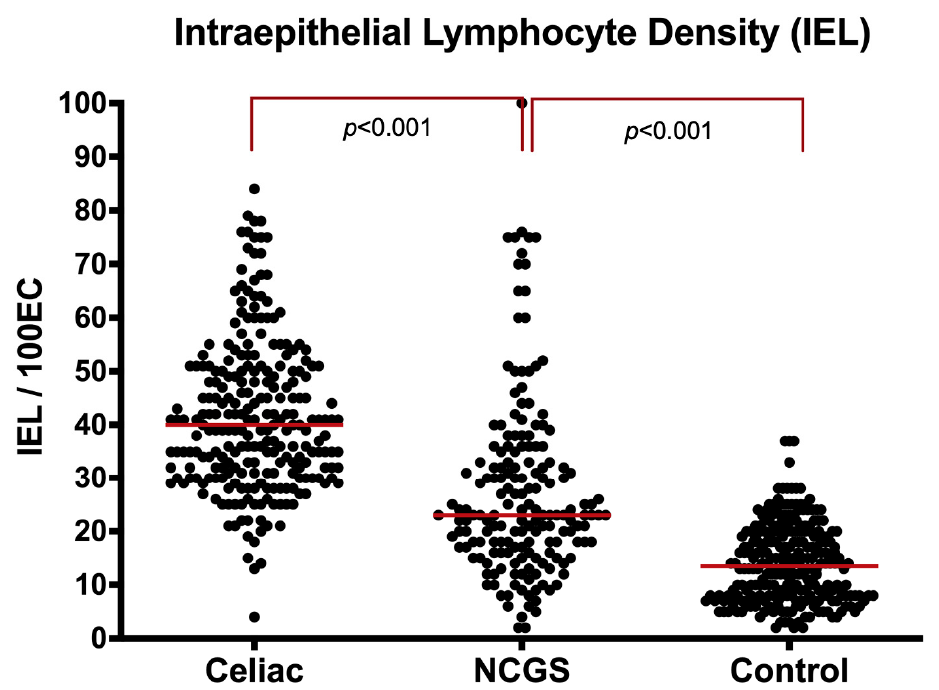
Figure 4. Intraepithelial lymphocytes (IELs) of villi in NCGS compared to CeD and controls, entire cohort.